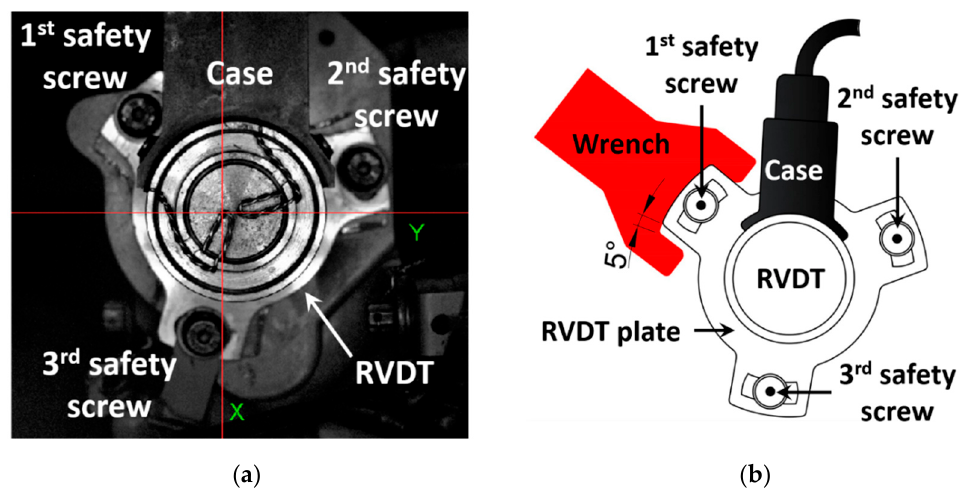
Figure 10. ( a ) Frontal view of the RVDT sensor and its three safety screws; ( b ) Schematic representation of the backlash between the wrench and RVDT plate.